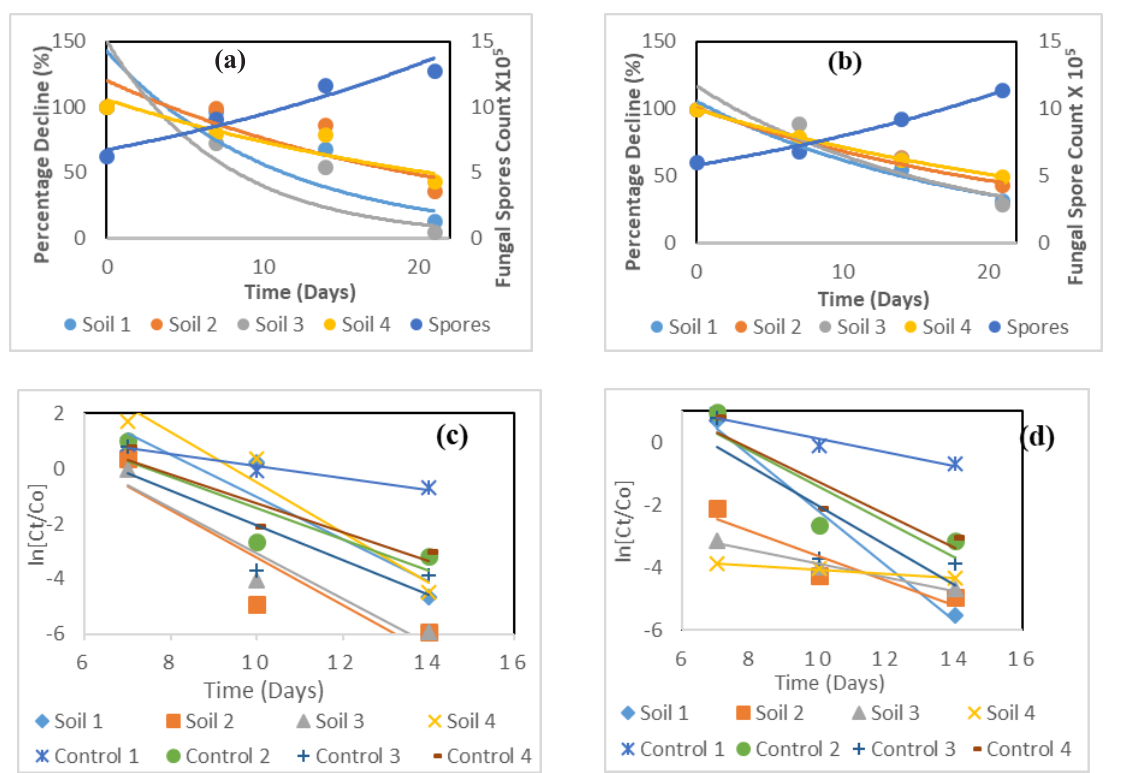
Figure 2: Biodegradation of BSM in soil samples (a) Percentage decrease in BSM concentration by A. niger . (b) Percentage decrease in BSM concentration by Penicillium chrysogenum . (c) Linear plot of ln[Ct/Co] for BSM by A. niger . (d) Linear plot of ln[Ct/Co] for BSM by Penicillium